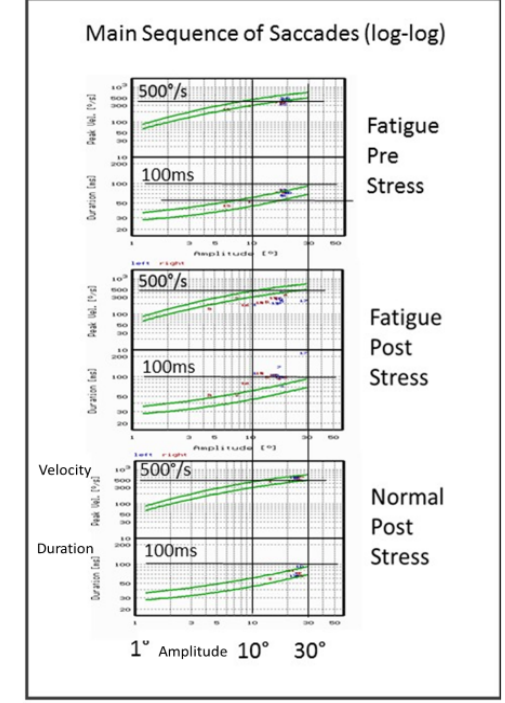
Figure 2. Characteristics of Main Sequence (log-log) graphs of MS fatigue patient SC before [pre] and after [post] stress test (upper two graphs), and a normal healthy subject for comparison (lowest graph) [post] stress test. Each panel shows peak velocity in deg/s upper, and duration (sec) lower as functions of amplitude (deg). Note the saccadic amplitude reduction and significant reduction of peak velocity after the stress test; falling below the two sigma main sequence limits of healthy subjects aged 20 to 60 in our